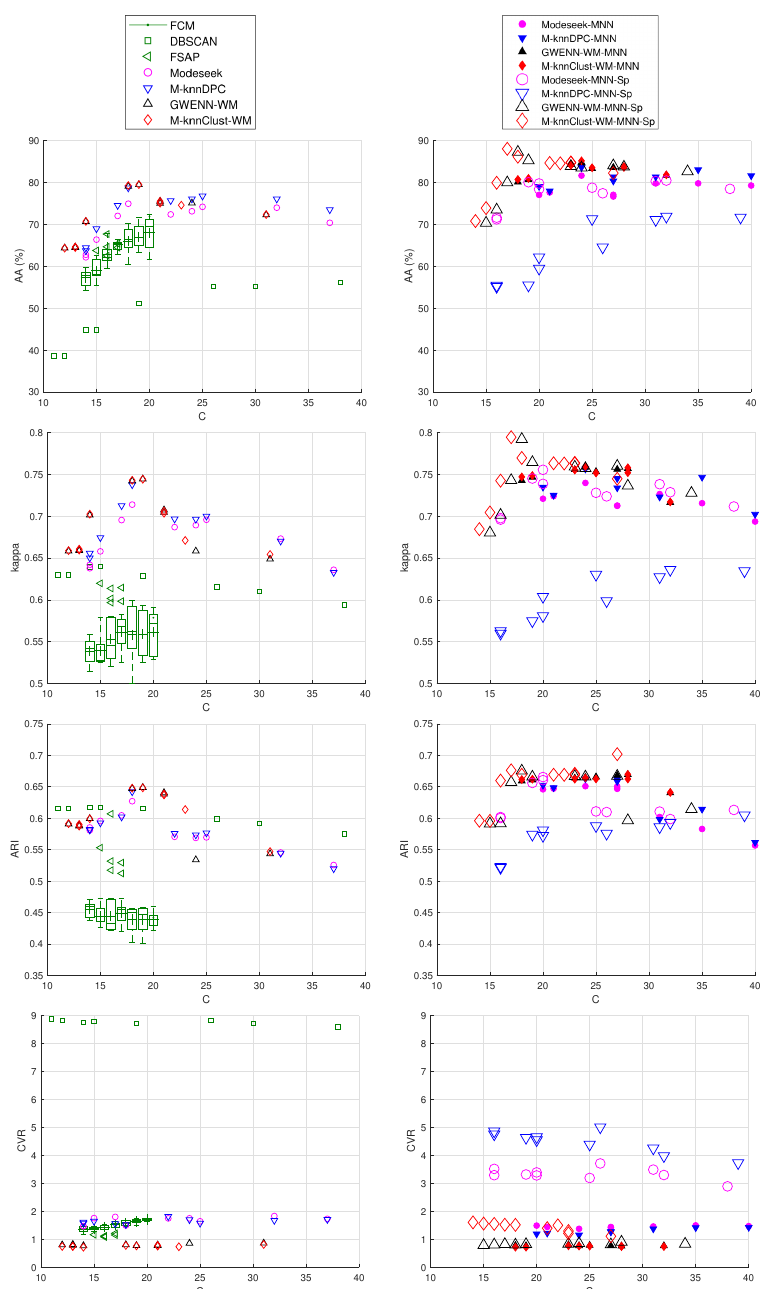
Figure 8. Clustering results of Salinas HSI as a function of the number of clusters. Left column: state-of-the-art methods and baseline nearest-neighbor methods; right column: HSI-improved nearest-neighbor methods. From top to bottom: average accuracy; kappa index; adjusted Rand index; consistency violation